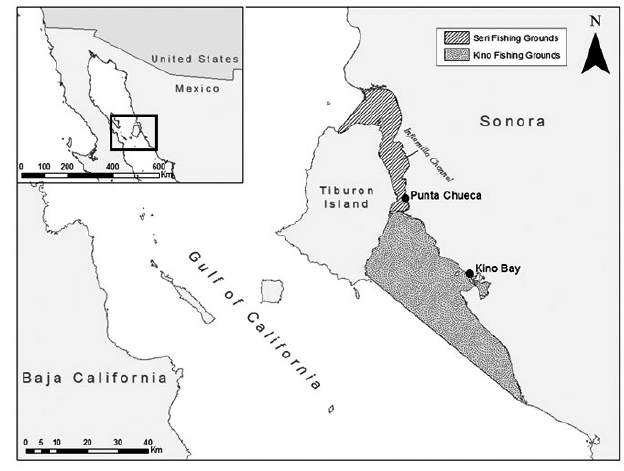
Fig. 1 . Map of the study area—Seri fishing